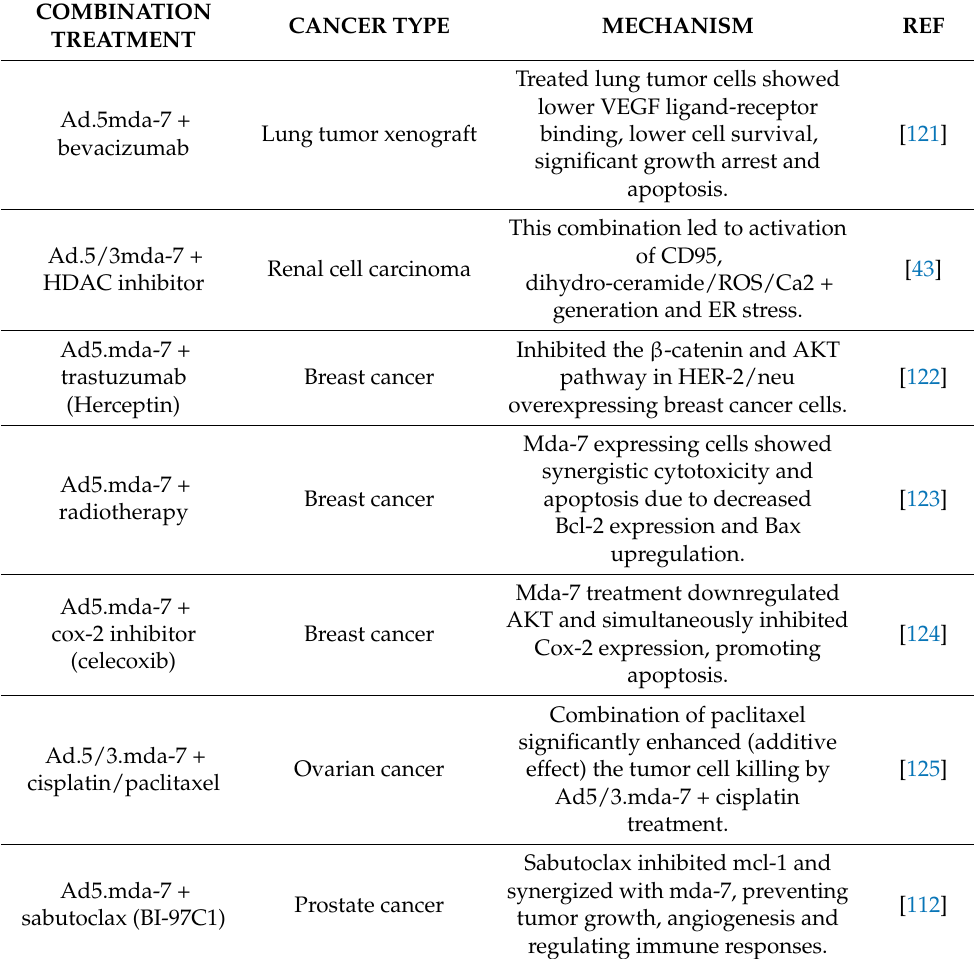
Table 1. Combinatorial therapy of combining mda-7/IL-24 with other therapeutic